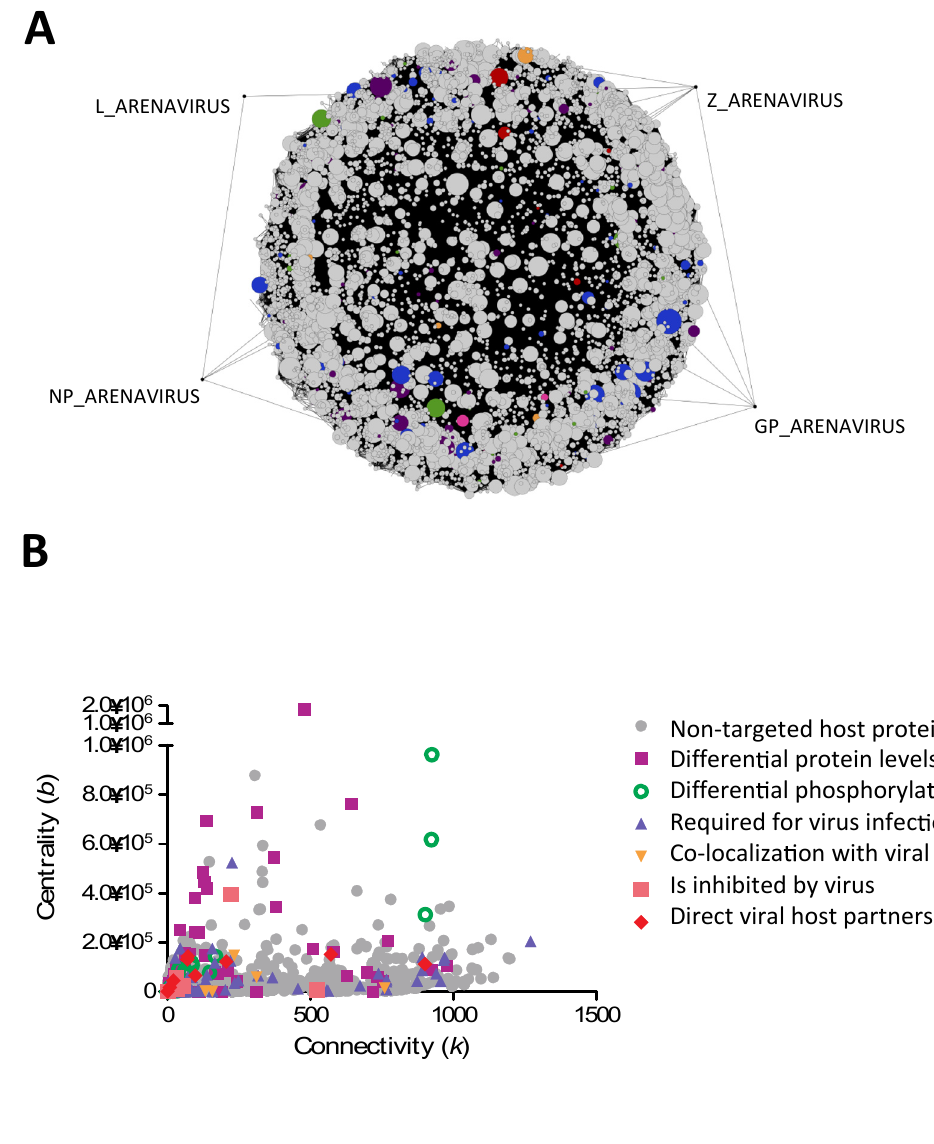
Figure 3. Common element network of arenavirus-host interactions, describing pathways targeted/perturbed during infection by all arenaviruses. ( A ) In this graphical representation, the arenaviral proteins (GP, NP, L and Z) are highlighted by dragging out of the main connected components, to facilitate visualization. Nodes are color-coded depending on role during arenavirus infection (see key in part b). Node size was correlated to node degree, to facilitate visualization of their relative importance within the network. Interested users can find the filter used to generate this network pre-loaded within the supplemental network file (Supplemental Data: Arenavirus-Host Full Network.cys; Filter name: Common elements of arenavirus replication). ( B ) Graphical representation of characteristics of nodes (connectivity and centrality values). Nodes of particular importance are revealed by high values in both parameters. The nodes are color-coded depending on their identified role during virus